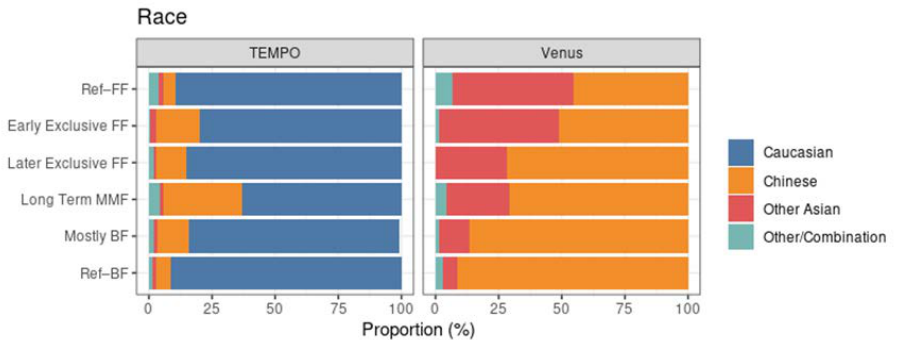
Figure 6. Race distribution within each MMF cluster, highlighting the population differences between TEMPO (left) and Venus (right).